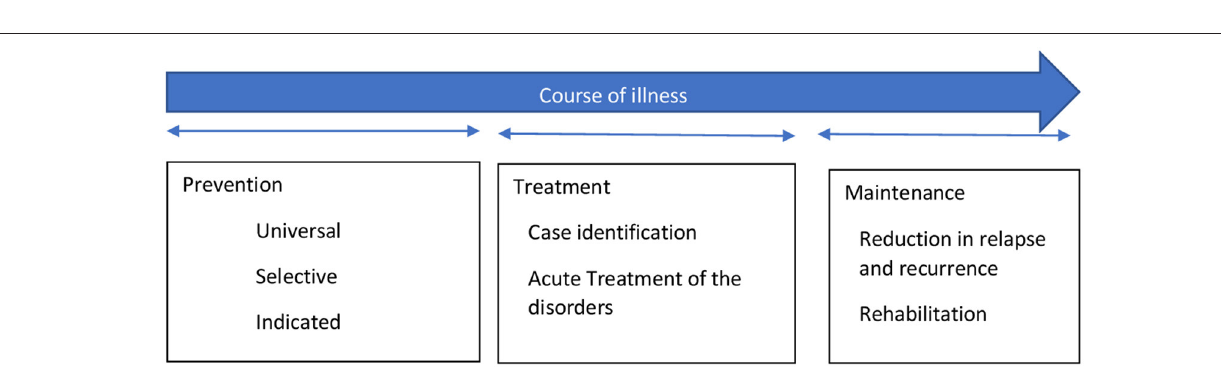
childhood vaccination are examples of preventative measures that have benefited both physical and mental health.